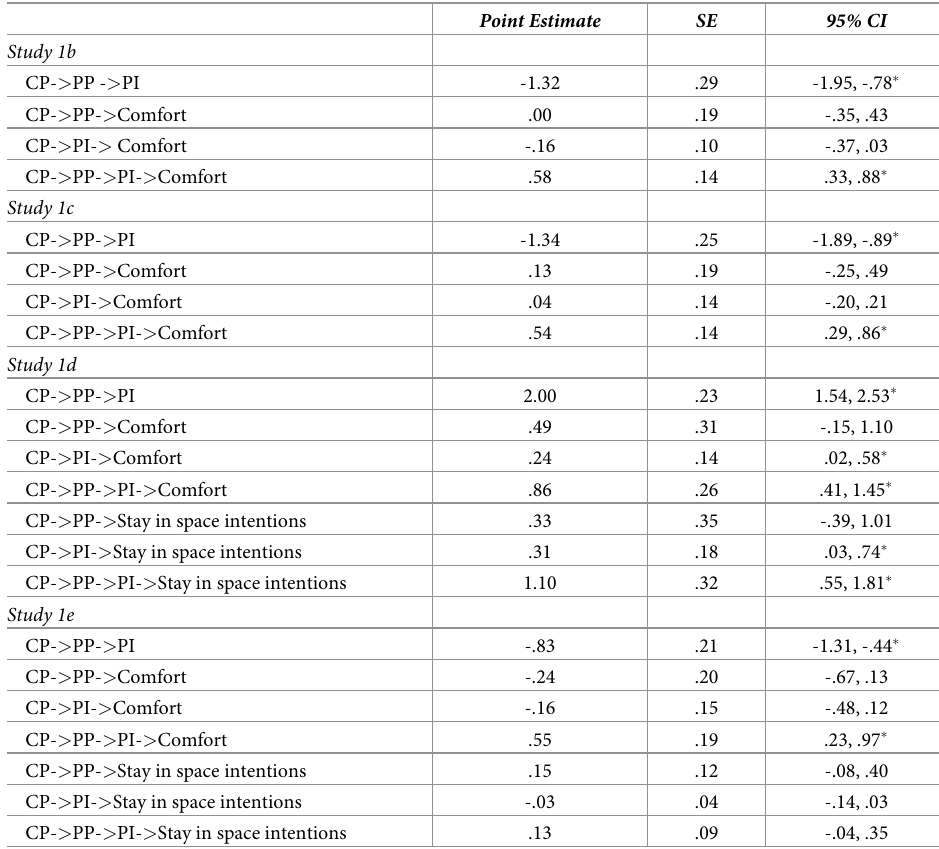
Table 3. Indirect effects for Study